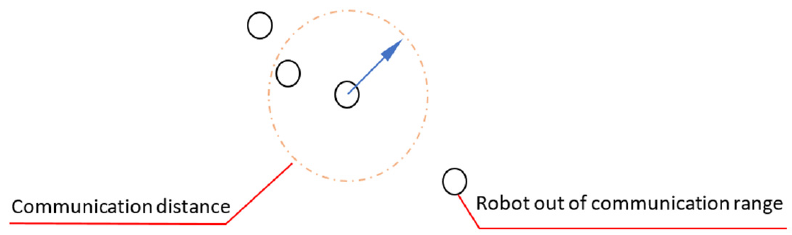
Figure 12. Robot out of communication range of the swarm. Algorithm 6 Solution: Exceeding the communication distance